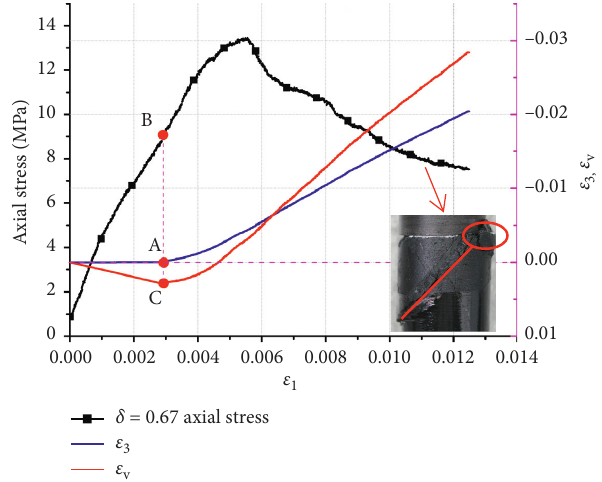
Figure 12: The relationship between axial strain-stress and circle and volume strain when confining pressure is 5